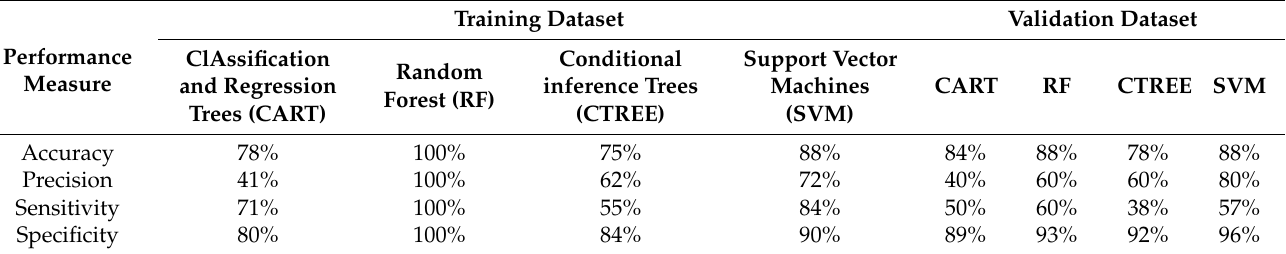
Table 10. Models’ evaluation of training and validation sets by classification